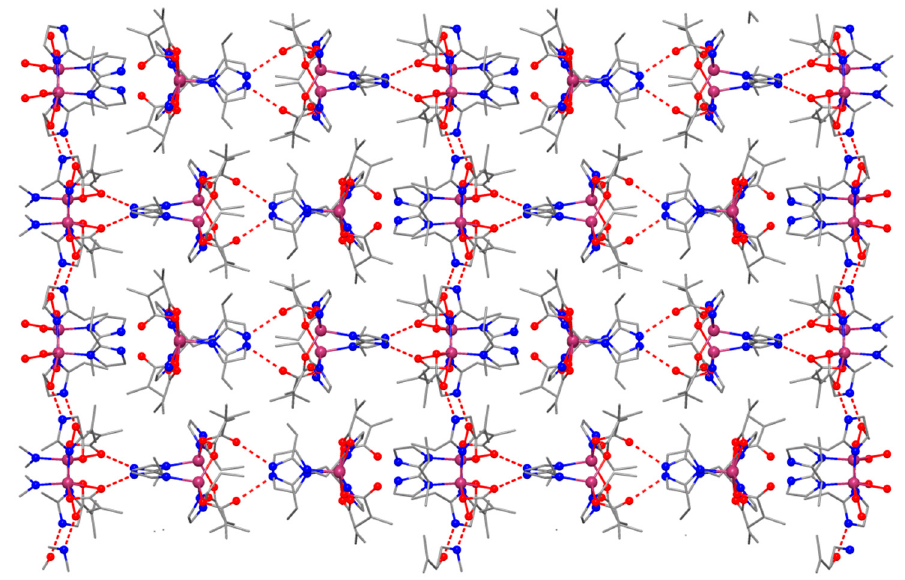
Figure 4. Packing diagram of ( 3 ) showing the supramolecular H-bonds network. Table 2. Selected bond distances (Å) for ( 1 )–( 3 ). Table 3. Infrared absorption bands (cm − 1 ) for ligands and complexes.